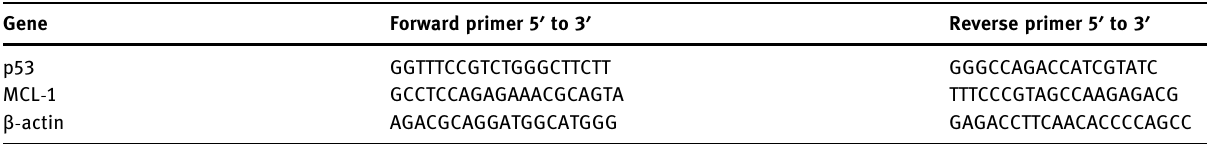
Table 3: Primer sequence used in real - time PCR Gene Forward primer 5 ′ to 3 ′